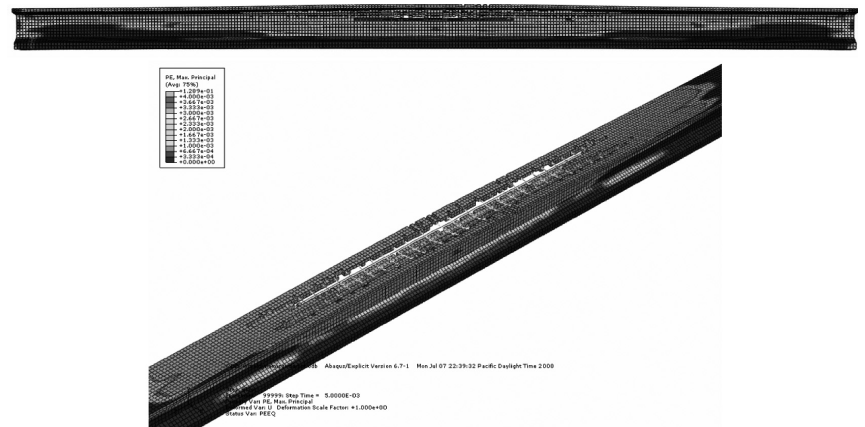
Fig. 14. Maximum principal plastic strain for blast below the